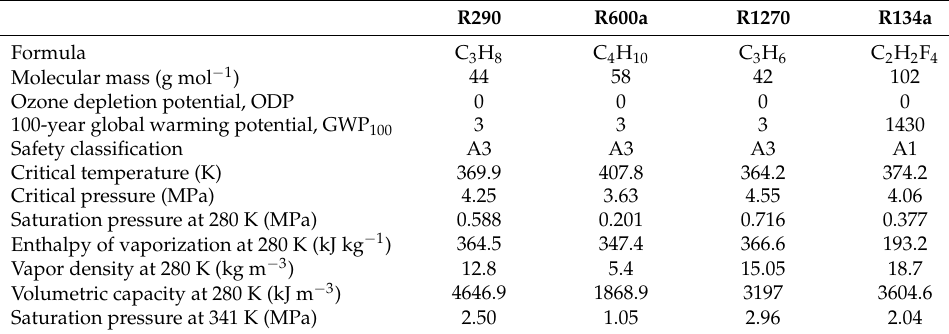
Table 1. Properties of baseline and alternative hydrocarbon